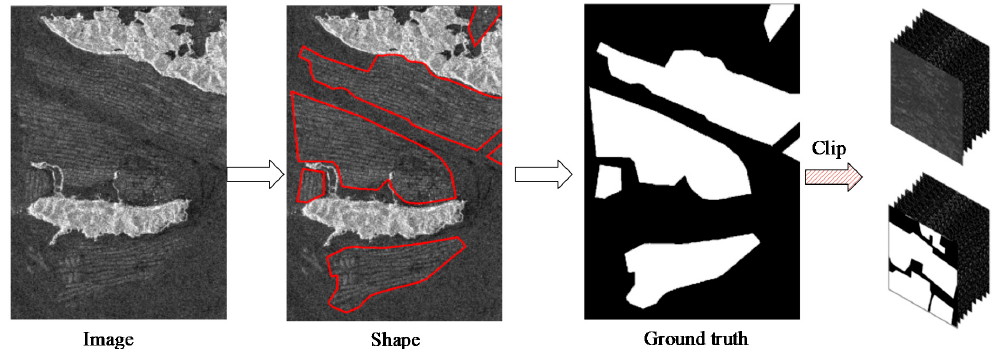
Figure 13. After selecting a data source, dataset construction requires three main steps: data labeling, generating a truth map, and cropping.